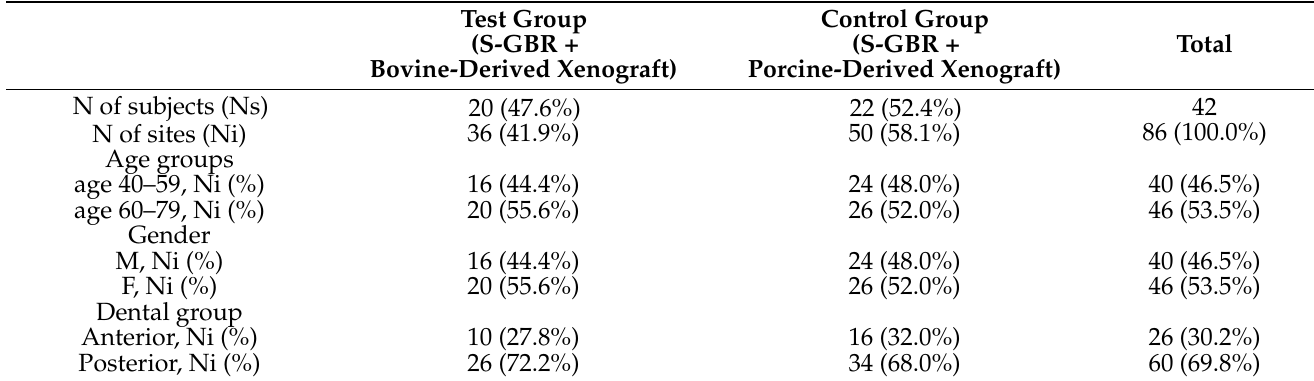
Table 1. Characteristics of test and control group.